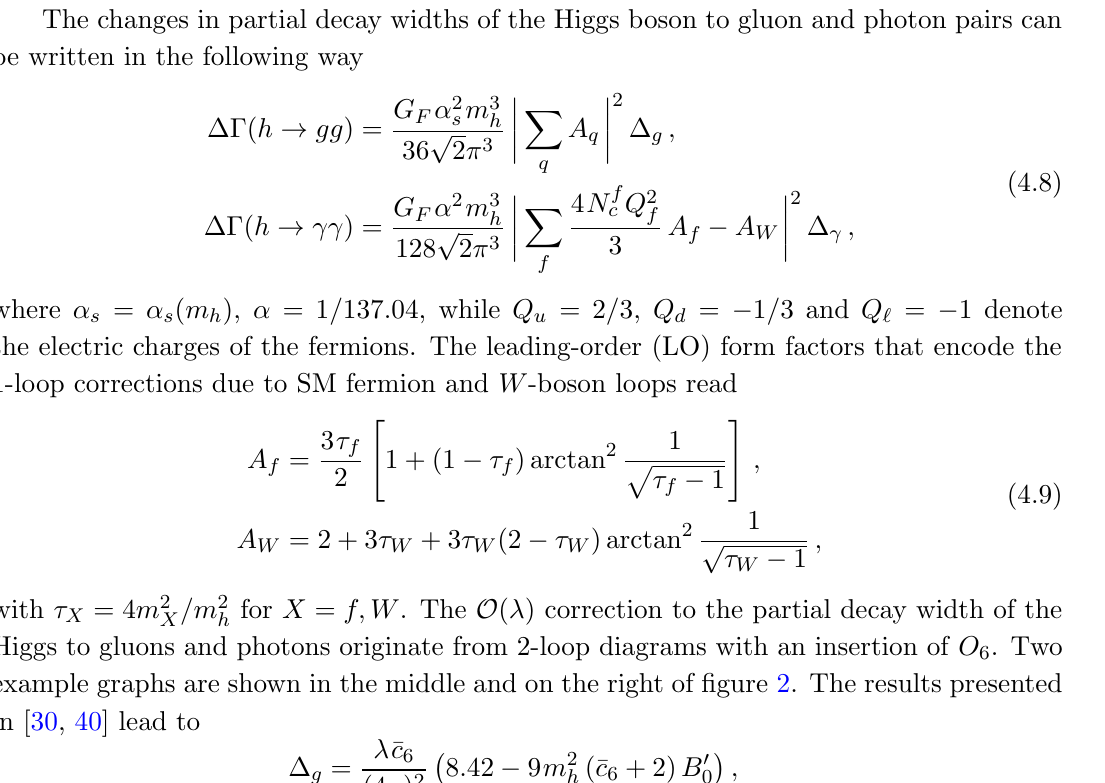
Figure 2 . Feynman diagrams with an insertion of the e(cid:11)ective operator O decays into fermion (left), gluon (middle) and photon (right) pairs. Here the arguments of the PV loop integrals are de(cid:12)ned as in (3.6). We have veri(cid:12)ed that the expression (4.4) agrees numerically with the results presented in